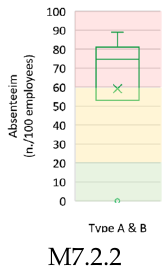
Figure 11. Results of the validation applied to the wastewater utilities: objective 7.